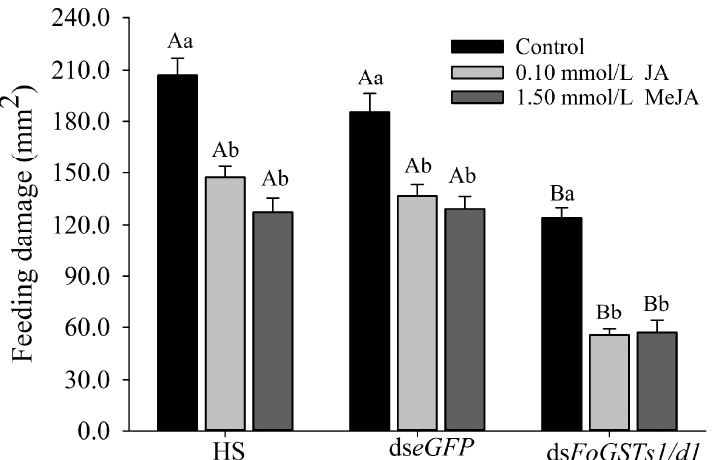
Figure 9. Co-silencing of FoGSTd1 and FoGSTs1 expression levels by RNA interference reduced the area of feeding damage on jasmonic acid (JA)- and methyl jasmonate (MeJA)-induced bean leaves by second-instar larvae of Frankliniella occidentalis . Values are the mean ± SE. Different lowercase letters indicate significant differences in feeding damage area on kidney bean leaves with different induction treatments by F. occidentalis fed the same RNAi solution. Different uppercase letters in- dicate significant differences in feeding damage area of kidney bean leaves with the same induc- tion treatment, but F. occidentalis was fed honey solution (HS) and ds eGFP and ds FoGSTs1/d1 solu- tions ( p < 0.05; one-way ANOVA, followed by Tukey’s test). Thrips were fed ds FoGSTs1/d1 solution then fed kidney bean leaves treated with dif- ferent induction factors (uninduced or induced by exogenous JA and MeJA) and feeding damage areas were measured. The area of feeding damage by F. occidentalis fed ds FoGSTs1/d1 solution decreased significantly compared with that of both the HS and ds eGFP -treated groups. In the control group, the area of feeding damage on kidney bean leaves by F. occidentalis fed ds FoGSTs1/d1 solution decreased significantly by 40.10% and 33.09% ( F 2, 15 = 22.344; p < 0.001), compared with F. occidentalis fed HS and ds eGFP , respec- tively. The damaged areas of the JA-induced treatment groups decreased significantly by 62.22% and 59.22%, respectively ( F 2, 15 = 30.856; p < 0.001), and those of the MeJA-induced treatment groups decreased by 55.24% and 55.87% ( F 2, 15 = 80.585; p < 0.001), respectively. 2.7. Co-Silencing of FoGSTd1 and FoGSTs1 by RNA Interference Reduces the Pupation Rate of Frankliniella Occidentalis The co-silencing of FoGSTd1 and FoGSTs1 expression levels significantly reduced the pupation rate of second-instar larvae of F. occidentalis fed exogenous JA- and MeJA-in- duced kidney bean leaves (Figure 10). In the group fed HS without dsRNA, the pupation rate of second-instar larvae of F. occidentalis feeding on exogenous JA- and MeJA-induced bean leaves decreased significantly by 21.25% and 26.98% ( F 2, 15 = 16.234; p < 0.001), respec- tively, compared with that in the control group. In the group fed ds eGFP solution, the pupation rate of second-instar larvae after feeding on JA- and MeJA-induced bean leaves decreased significantly by 14.29% and 15.75% ( F 2, 15 = 6.012; p = 0.012), respectively, com- pared with that feeding on the control. In the group fed ds FoGSTs1/d1 solution, the pupa- tion rate of second-instar larvae that fed on JA- and MeJA-induced bean leaves decreased